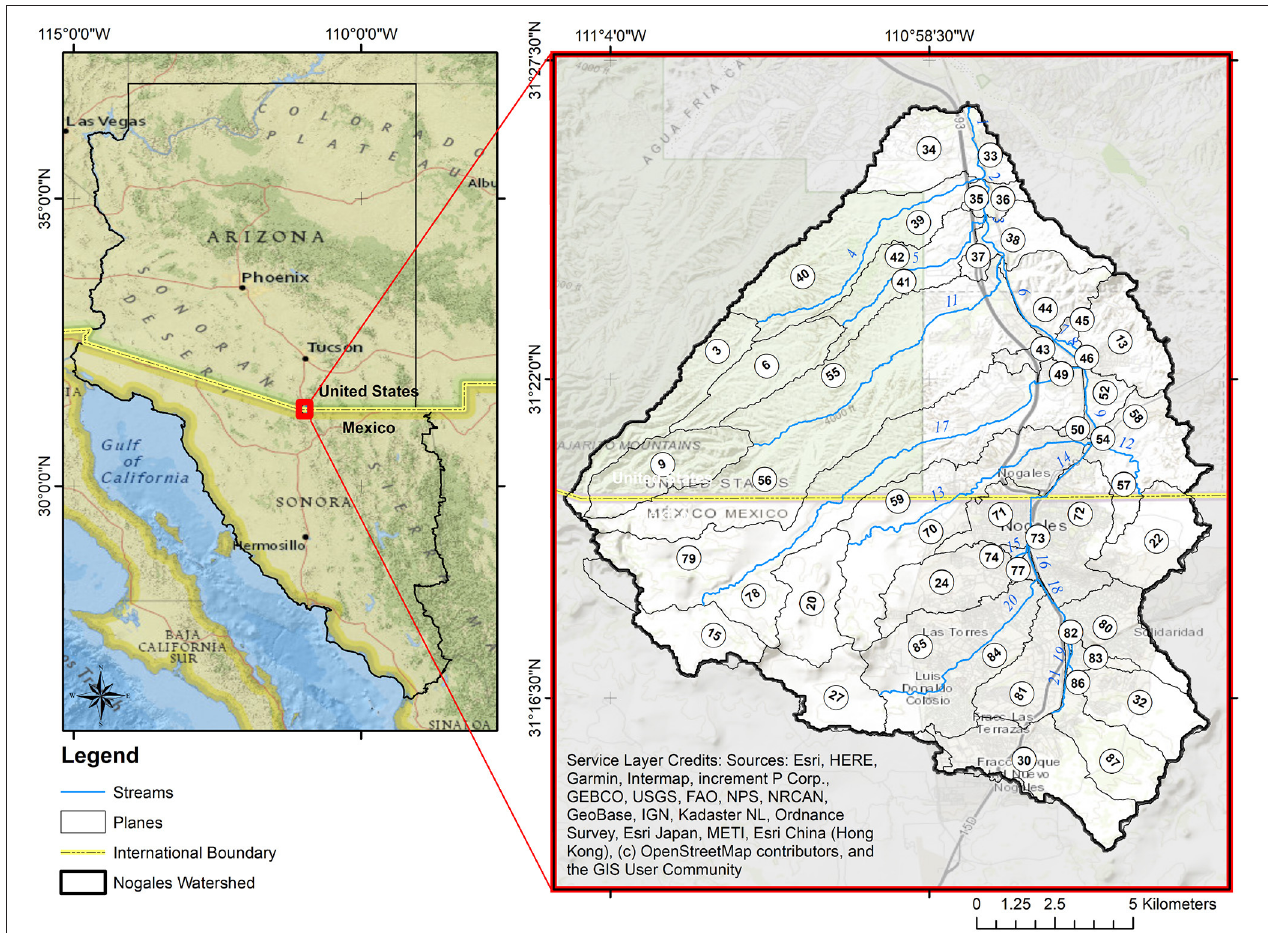
FIGURE 1 | Nogales, Arizona, and Nogales, Sonora (Ambos Nogales), are located on the United States-Mexico border. Plane and stream numbers are labeled based on KINEROS2